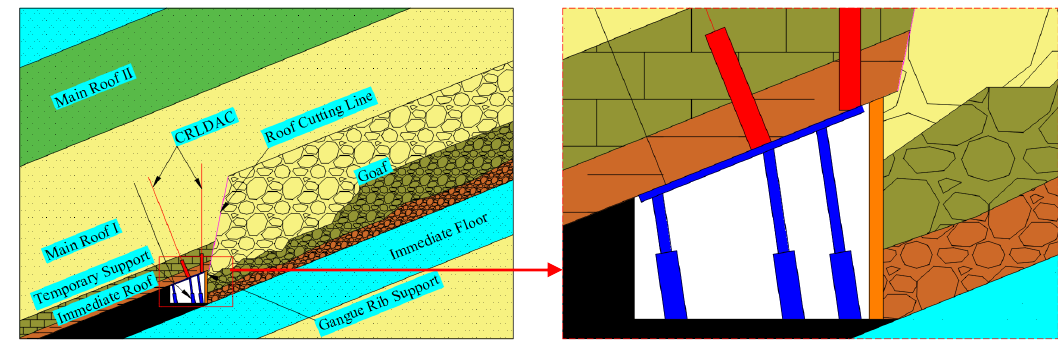
Figure 4. Temporary support in the entry.